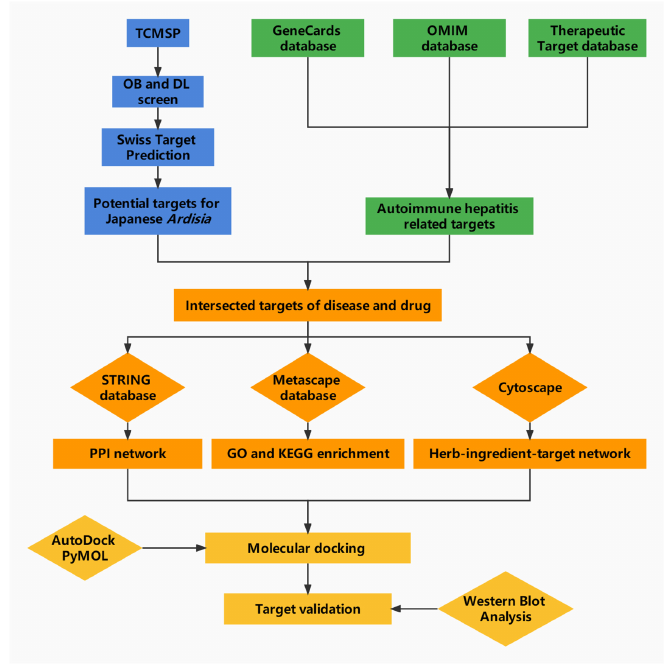
Figure 1. Network pharmacology analysis workflow.